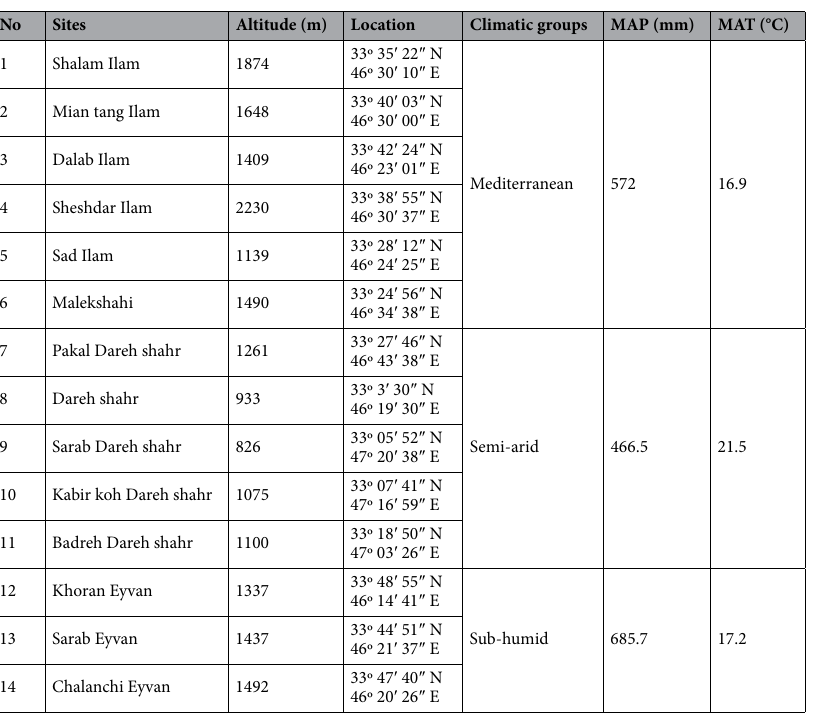
Table 4. Basic characteristics of the Quercus brantii forests sampled in this work. MAP (mm): Mean annual precipitation, MAT (°C): Mean annual temperature.